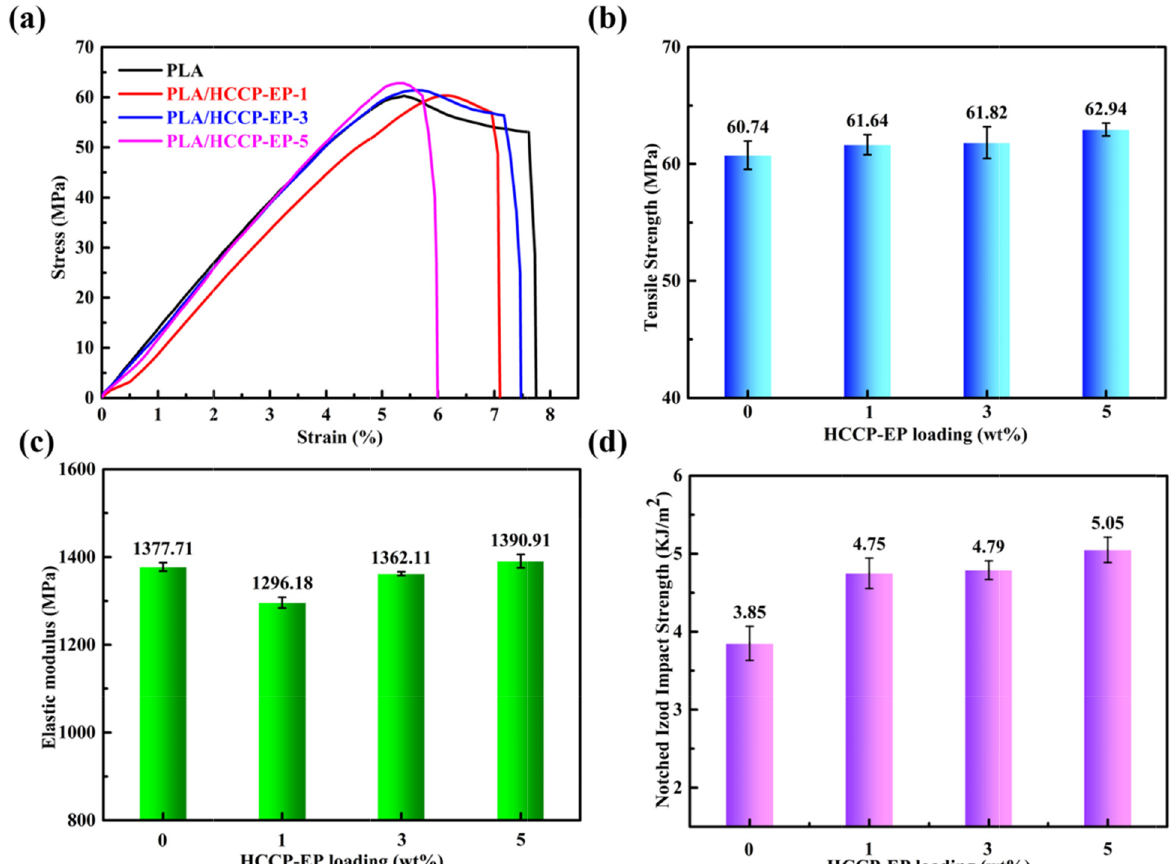
Figure 12: ( a ) Stress – strain curves of PLA and PLA/HCCP - EP blends. ( b ) Plots of tensile strength against loading of HCCP - EP. ( c ) Plots of elastic modulus against loading of HCCP - EP. ( d ) The notched izod impact strength of PLA/HCCP - EP blends.